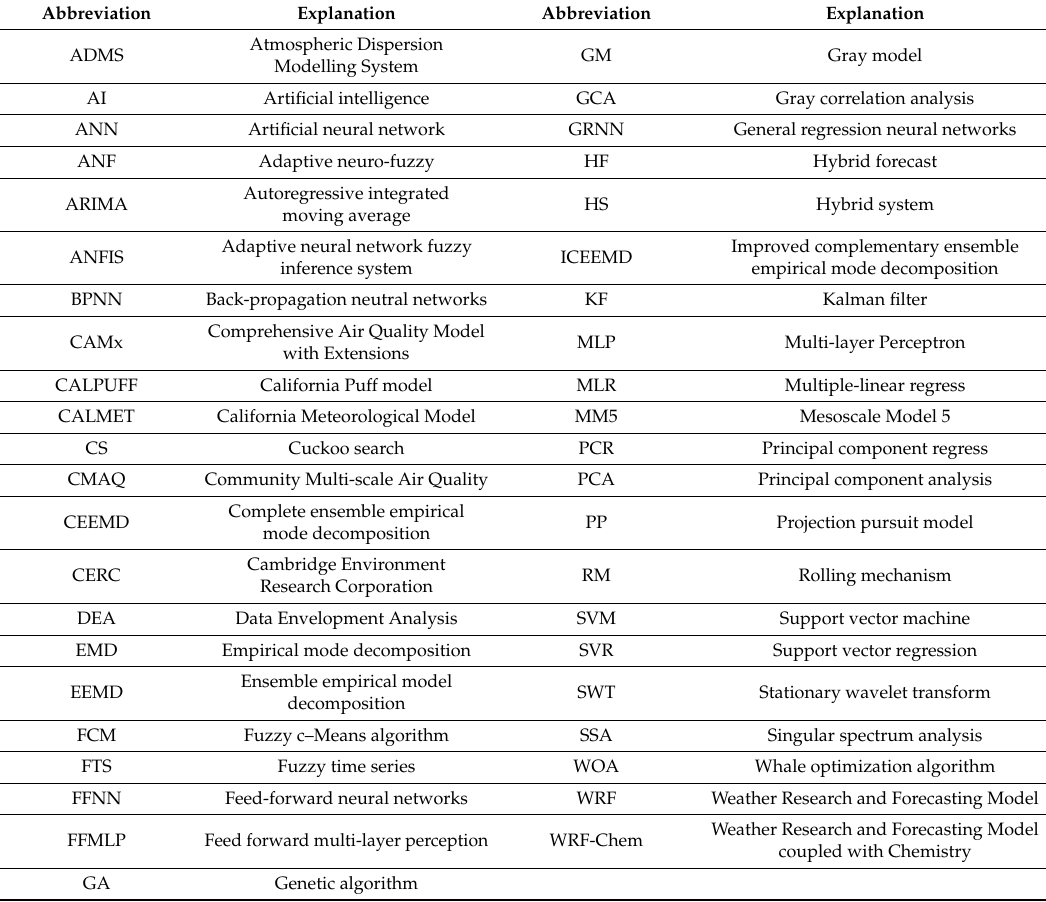
Table 2. Nomenclature of methods.